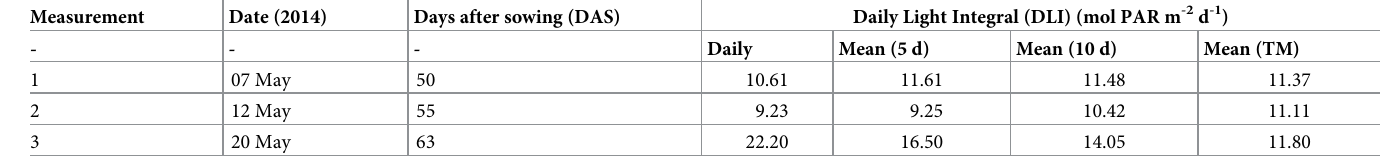
Table 1. Daily light integral (DLI) at three measurement dates, means across five (5 d) and ten days (10 d) prior, and the average from transplanting to the three measurement dates (TM).